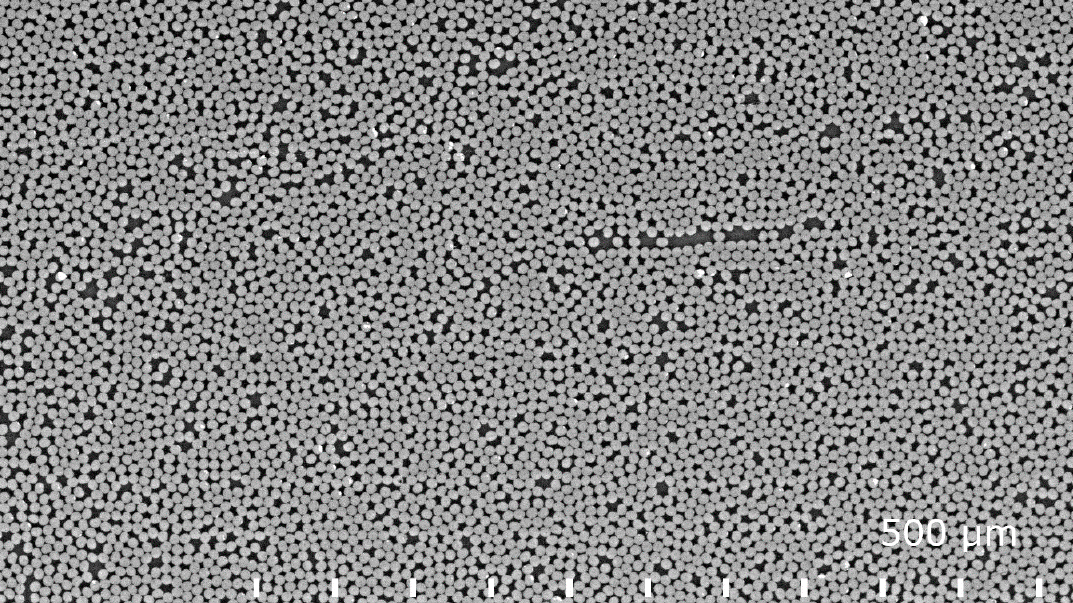
Figure 5. Electron backscatter image distinguishes between fiber and matrix due to a difference in average atomic number (Z contrast).